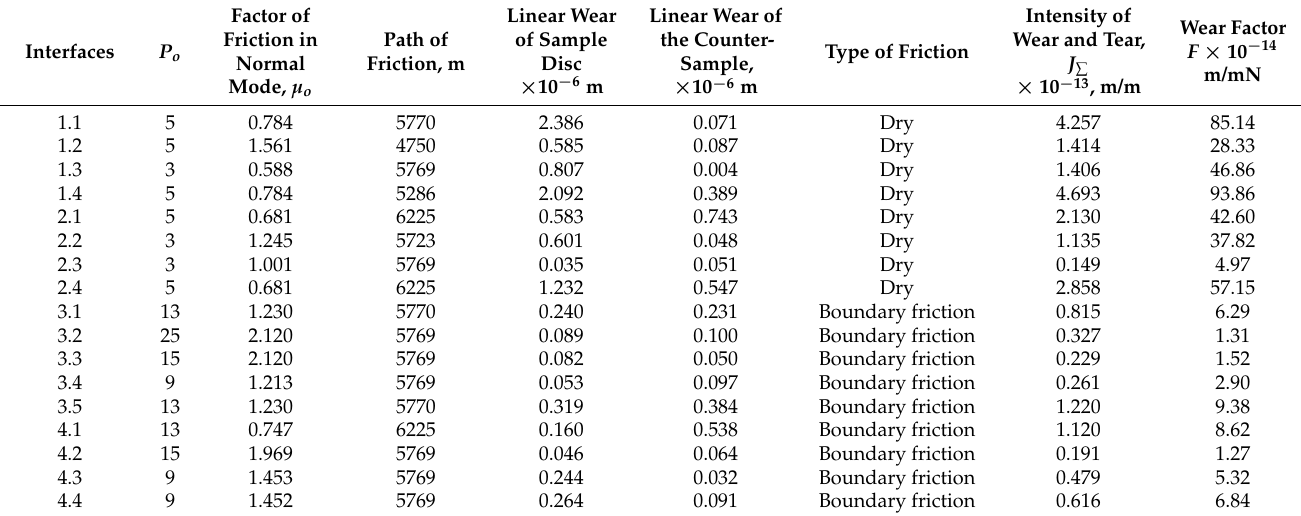
Table 7. The results of the test interfaces for